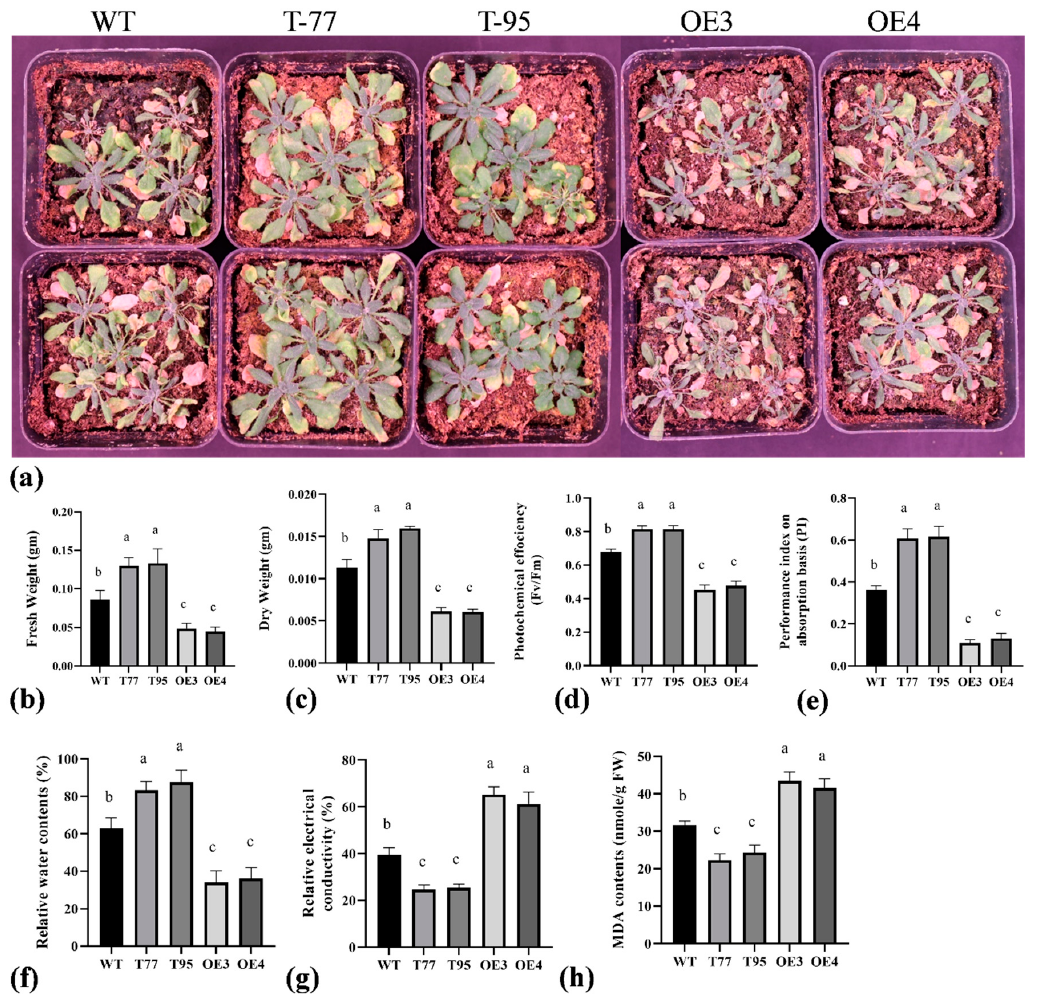
Figure 6. Comparison of drought stress tolerance of overexpressing TrHSFB2a lines and RNA interference T-DNA lines with wild type grown in nutrient soil by withholding water of 25 days old plants for up to two weeks. ( a ) Show phenotypes of wild, T-DNA lines and overexpression lines at 12 d of water withholding; ( b – h ) display a graphical representation of different phenotypic and physiological indicators of stress tolerance. ( b ) fresh weight; ( c ) dry weight; ( d ) photosynthetic efficiency (Fv/Fm); ( e ) performance index on absorption basis; ( f ) relative water contents (%); ( g ) Relative electrical conductivity (%); ( h ) MDA contents. Different alphabetic characters on bars represent statistically significant differences among variables.